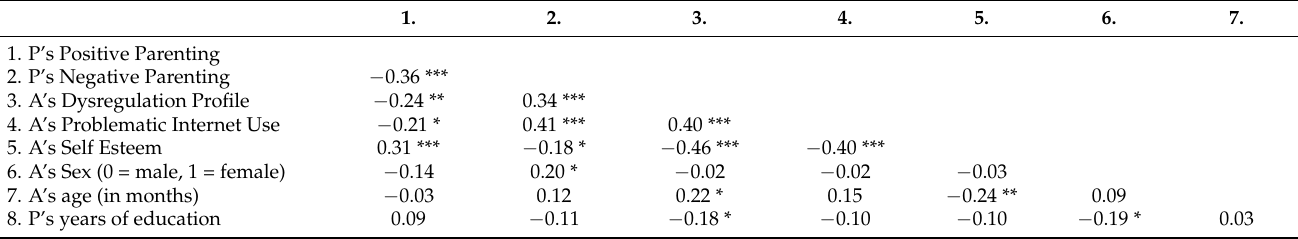
Table 2. Bivariate correlations among the study